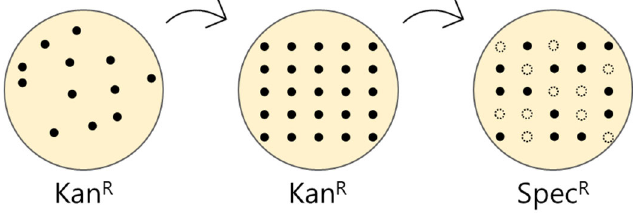
Figure 4. Schematic of the screening of the self-ligated vector transformant. Table 8. PCR components and thermal conditions for the first insert. Item Concentration Amount